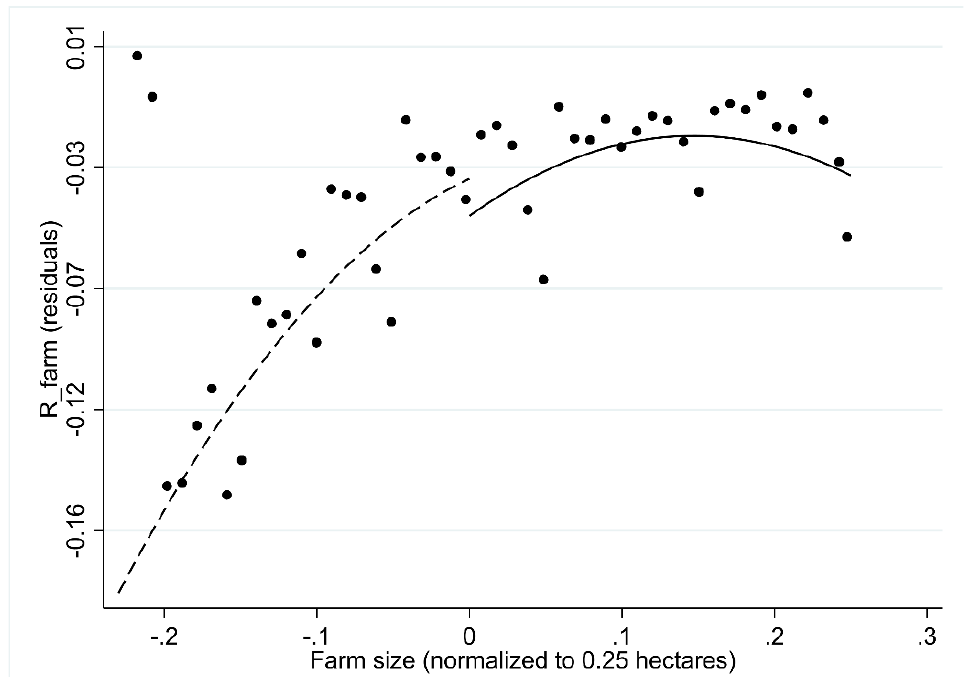
Figure 2. The effects of the anti-land fragmentation policy on the ratio of farmland production to total land. Note: the running variable is the size of farmland normalized to 0.25 hectare. The dashed and solid line are the non-parametric local-polynomial-based fits of the value of the ratio of the farmland used for farm production, after controlling for the explanatory variables.